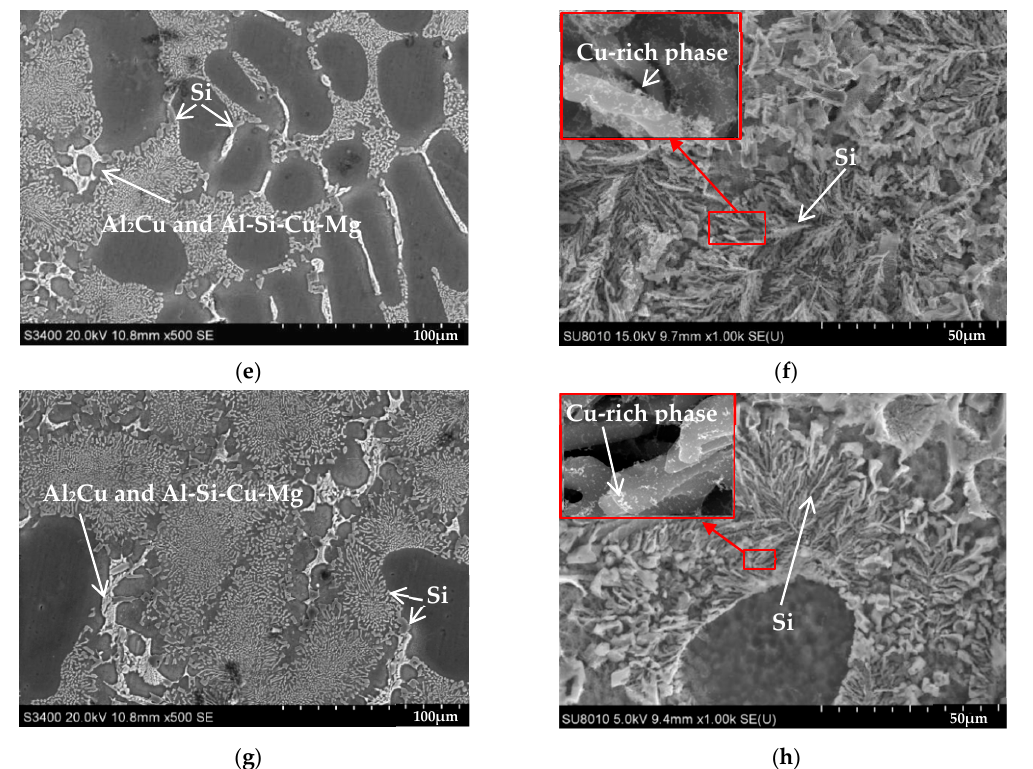
Figure 7. Effect of alloying elements on the SEM microstructure of Al-Si alloys: ( a ) Al-10Si-0.3Mg; ( b ) Al-10Si-0.3Mg (deep corrosion); ( c ) Al-10Si-0.3Mg-0.2Er; ( d ) Al-10Si-0.3Mg-0.2Er (deep corrosion); ( e ) Al-10Si-3Cu-0.3Mg; ( f ) Al-10Si-3Cu-0.3Mg (deep corrosion); ( g ) Al-10Si-3Cu-0.3Mg-0.2Er; ( h ) Al-10Si-3Cu-0.3Mg-0.2Er (deep corrosion).